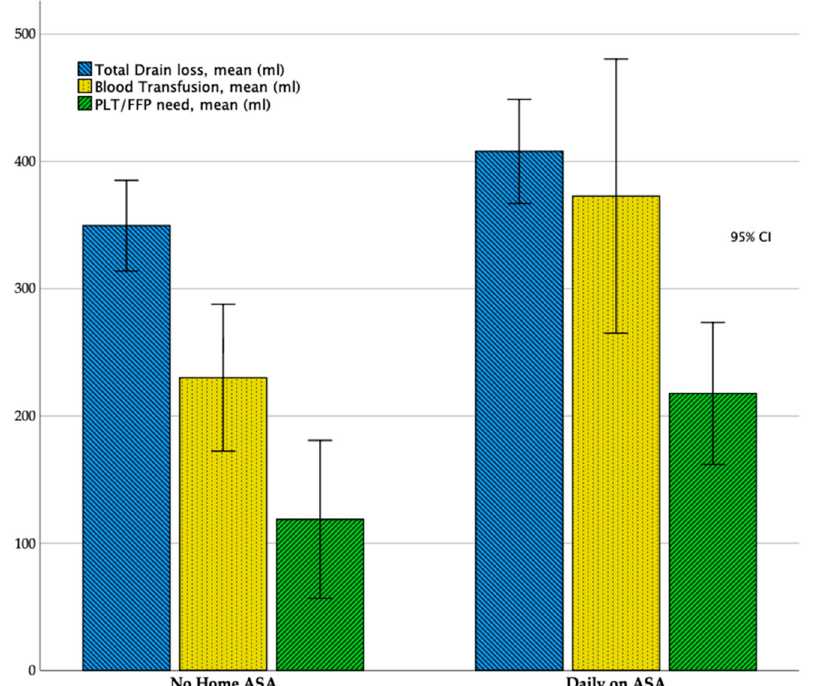
Figure 2. Bar chart showing results of the comparison in Total Drain Loss, Blood and Fresh Frozen Plasma / Platelet (FFP / PLT) transfusions between the two groups. Results are shown as mean value; 95% Confidence Intervals (CI) are reported.